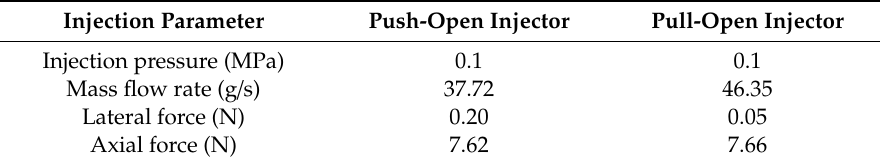
Table 1. Mass flow rates and forces su ff ered by the